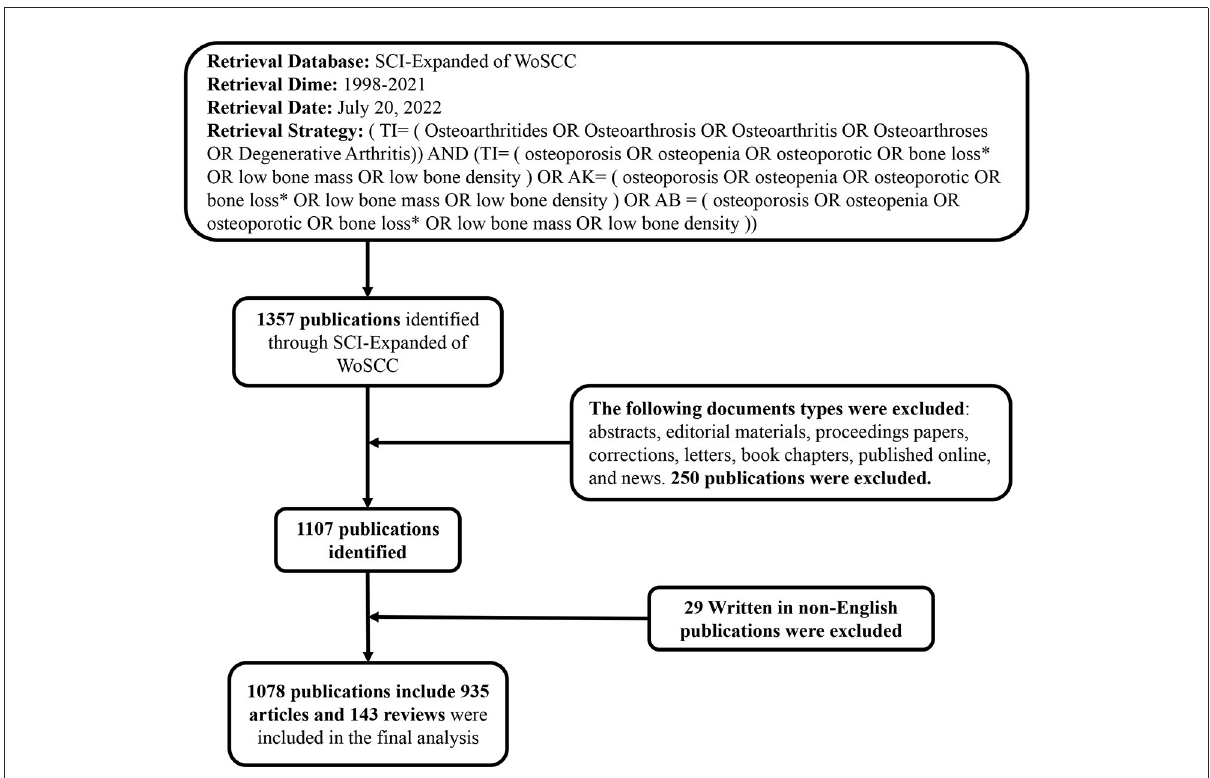
FIGURE1 Flowchart for the selection of literature included in the study.